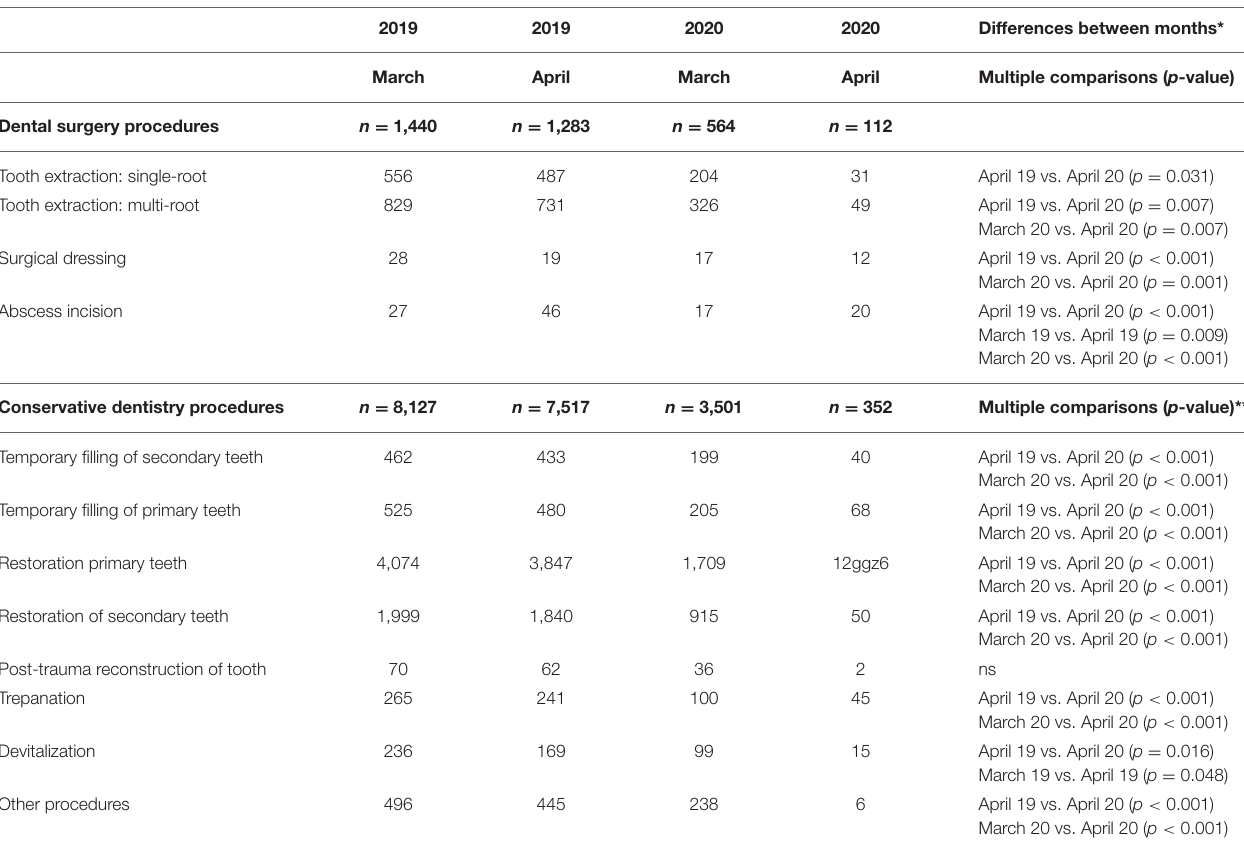
TABLE 1 | The statistical comparison in the number of dental service procedures for surgery and conservative dentistry (primary and secondary dentition) performed in March and April 2019 and 2020 y.